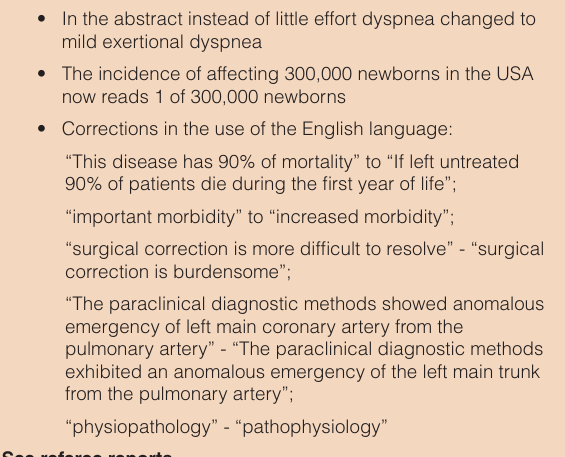
leaving the previously constructed duct in the back of the Dacron graft. The surgical findings were: right coronary (RCA) dilated and collateral circulation from RCA to left ventricular circulation, LMA arising from the MPA, dysplasia of posterior mitral